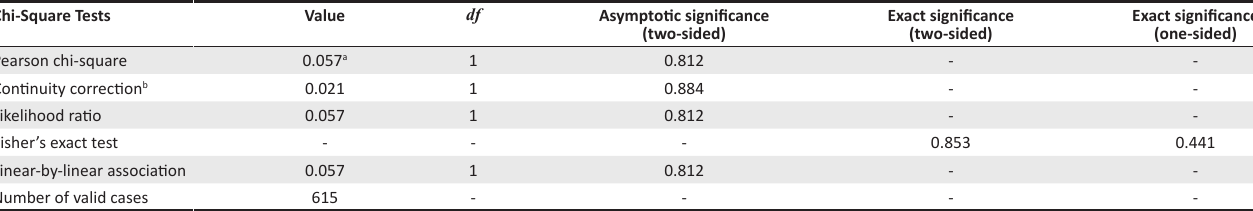
TABLE 4: Chi-square tests for independence. Chi-Square Tests